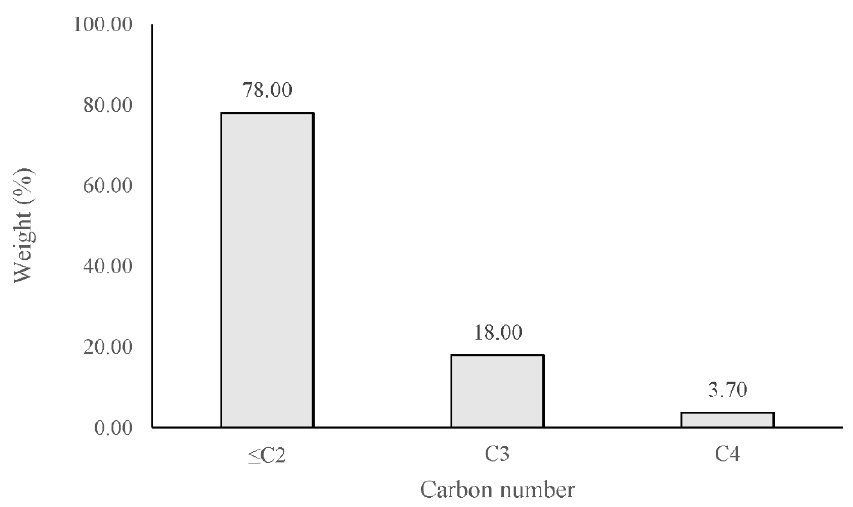
Figure 11. Hydrocarbon composition (by number of carbons) of isothermal pyrolysis gas.